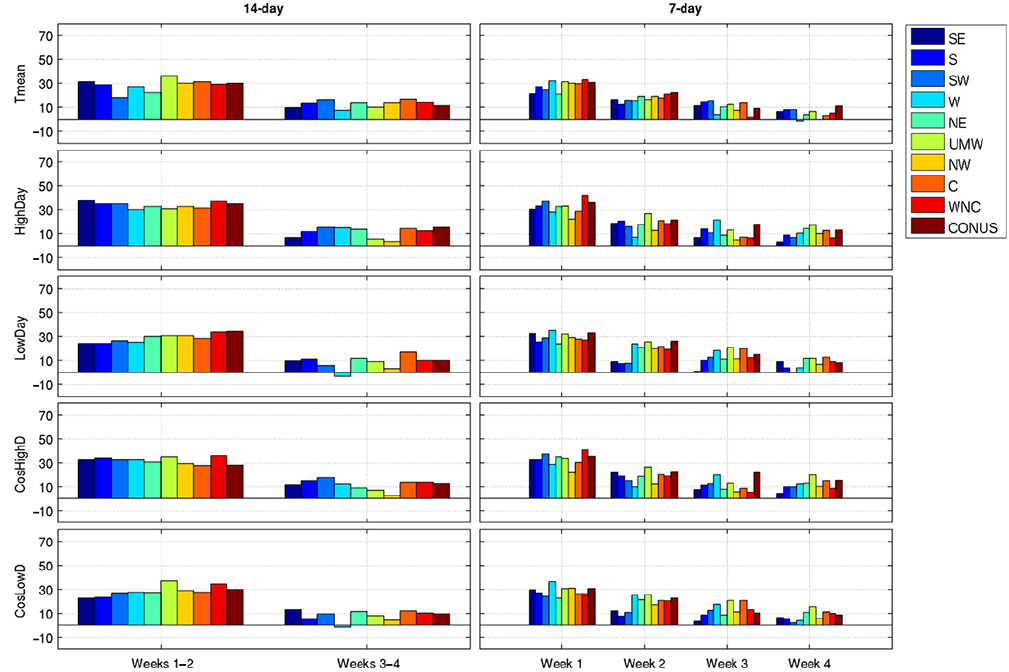
Figure 10. Mean HSS of 14- and 7-day (from top to bottom rows) T mean , HighDay, LowDay, CosHighD, and CosLowD from the CFSv2 daily hindcasts for the CONUS and its consistent NCEI climate regions.